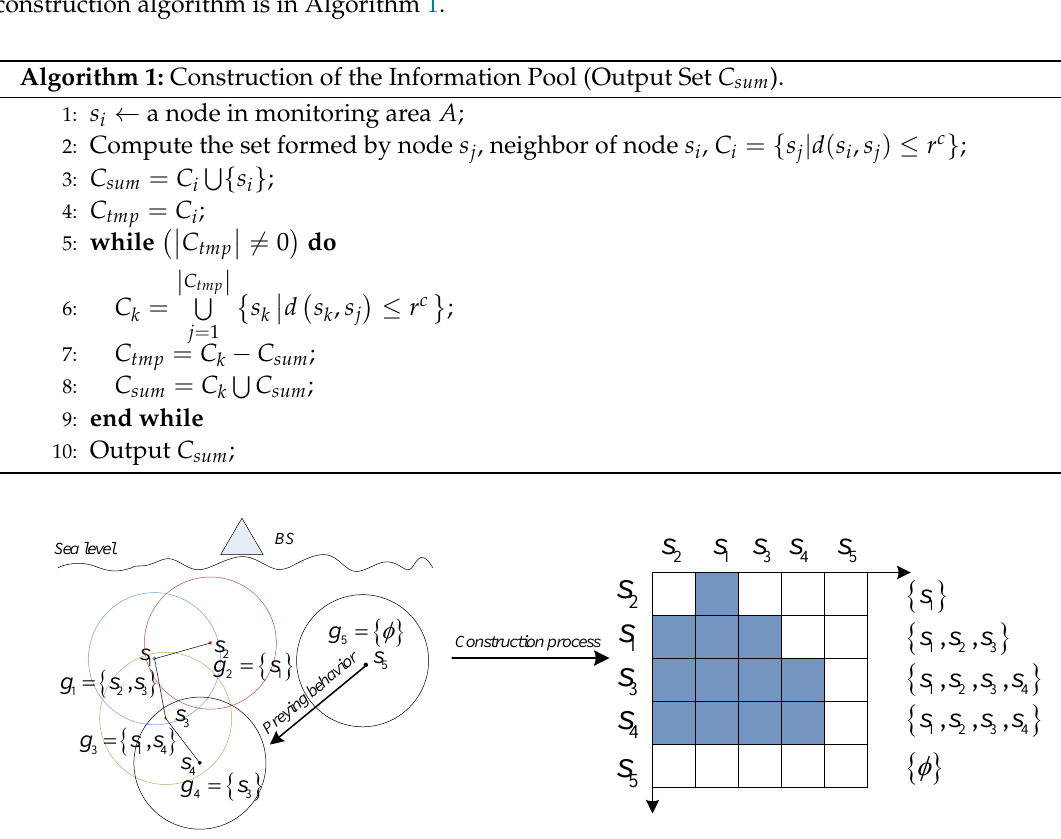
Figure 3. An example of information pool construction (there is an isolated node s 5